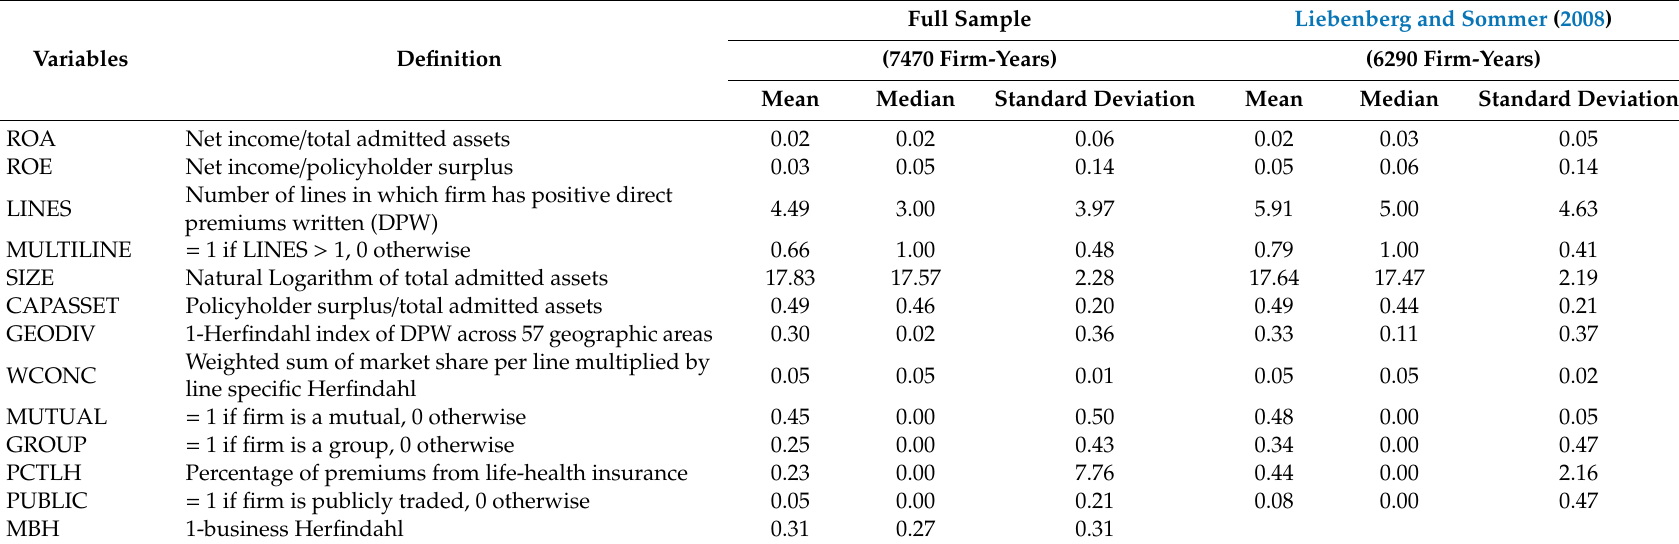
Table 1. Variable definition and descriptive statistics compared with that in Liebenberg and Sommer